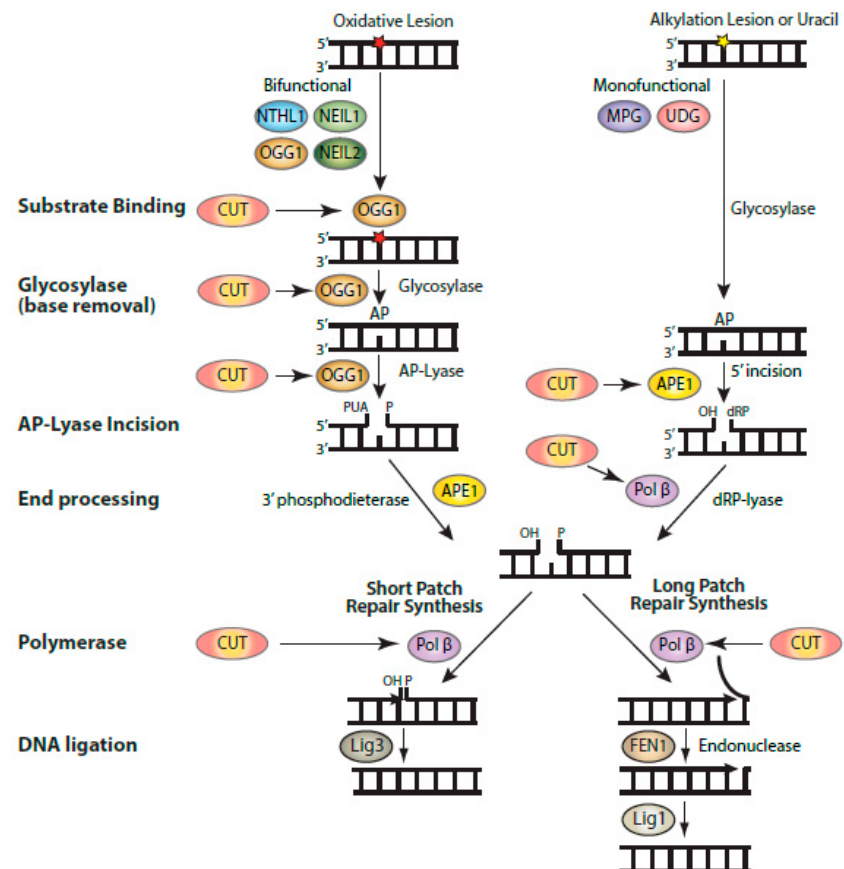
Figure 3. Biochemical activities of CUT domains in base excision repair. Diagrammatic representation of the steps involved in base excision repair, showing the enzymatic reactions that were found to be stimulated by CUT domains: substrate binding by OGG1, the glycosylase and AP-lyase activities of OGG1, the 5 ′ -incision by APE1, and the polymerase and strand-displacement activities of DNA pol β . Base excision repair (BER) is initiated by a DNA glycosylase that is specific for the particular type of altered base [82]. DNA glycosylases for oxidized bases (OGG1, NTHL1, NEIL1, and NEIL2) carry out two enzymatic reactions: the glycosylase activity removes the oxidized base, while the AP-lyase activity introduces a single-strand break with a 3 ′ -phospho- α , β -unsaturated aldehyde (3 ′ -PUA) in the case of OGG1. This 3 ′ -PUA is converted to a 3 ′ -OH by the 3 ′ -phosphodiesterase activity of APE1. UDG and MPG are monofunctional and only carry out the gly- cosylase activity, following which APE1 produces a single-strand incision with a 5 ′ -deoxyribose phosphate (5 ′ -dRP). This 5 ′ -dRP is converted into a 5 ′ -phosphate through the dRP-lyase activity of Pol β , which also introduces a single nucleotide in short-patch repair. It is not clear whether Pol β dRP-lyase activity or polymerase activity takes place first. When the 5 ′ dRP is not removed, the pathway switches to long-patch repair, whereby a stretch of 2–13 nucleotides is synthesized by Pol β or Pol δ / ε aided by PCNA and RFC (not shown here). Not shown in this diagram is the XRCC1 scaffolding protein which interacts with Pol β and Lig3. 5. Role of CUT Domain Proteins in the Resistance of Cancer Cells to Radiotherapy and Chemotherapy Cancer cells in which the RAS pathway is activated produce elevated levels of reac- tive oxygen species (ROS) which cause oxidative DNA damage and, ultimately, cellular